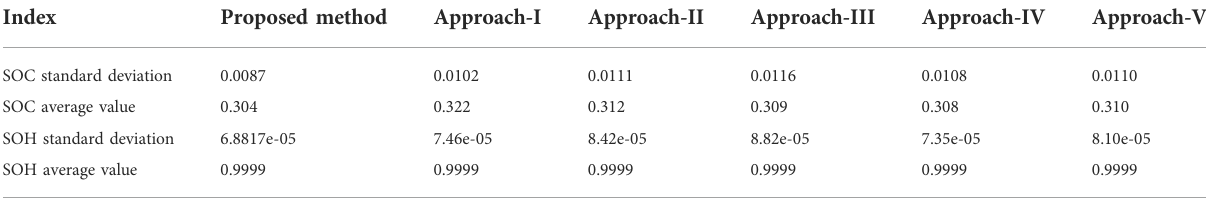
TABLE 4 Comparison of SOC and SOH regulated by various